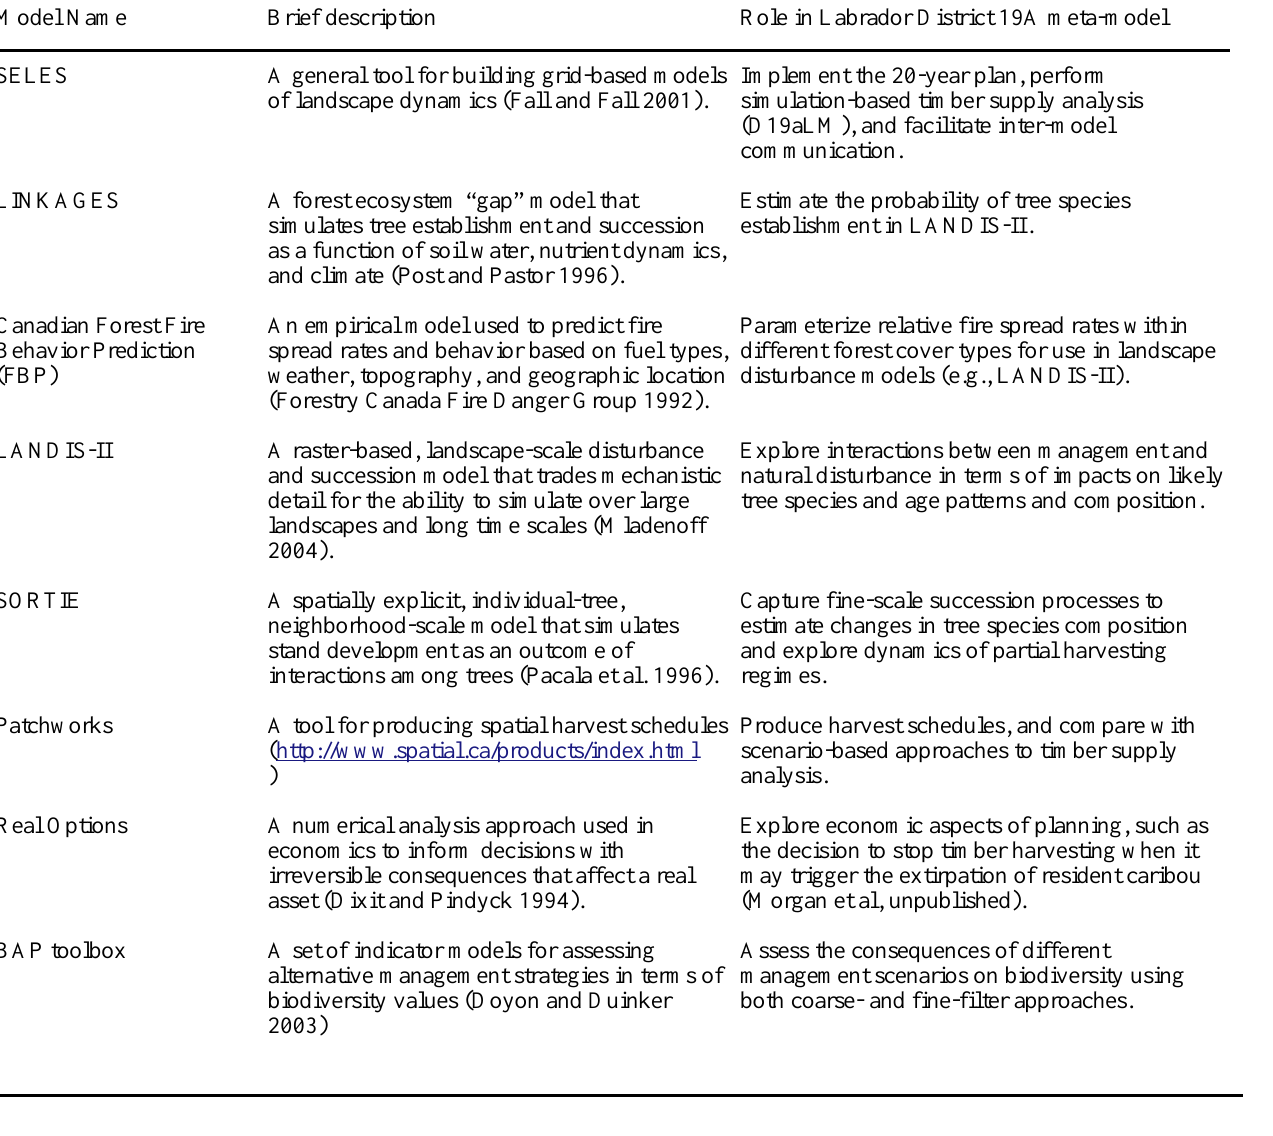
Table 1. Brief descriptions for specific modeling tools applied to the Labrador case study (Figure 5). More details, modeling examples, and links to supporting information are in the